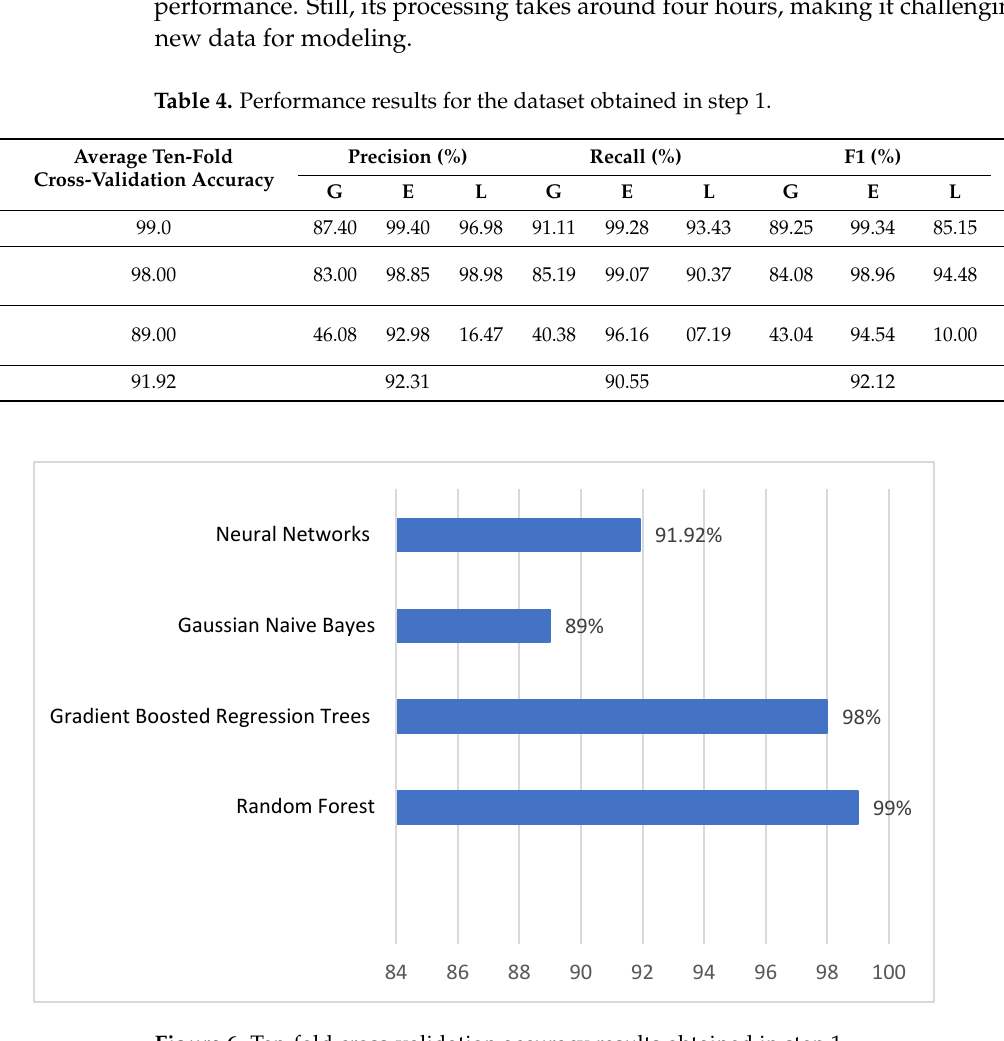
Table 4. Performance results for the dataset obtained in step 1.